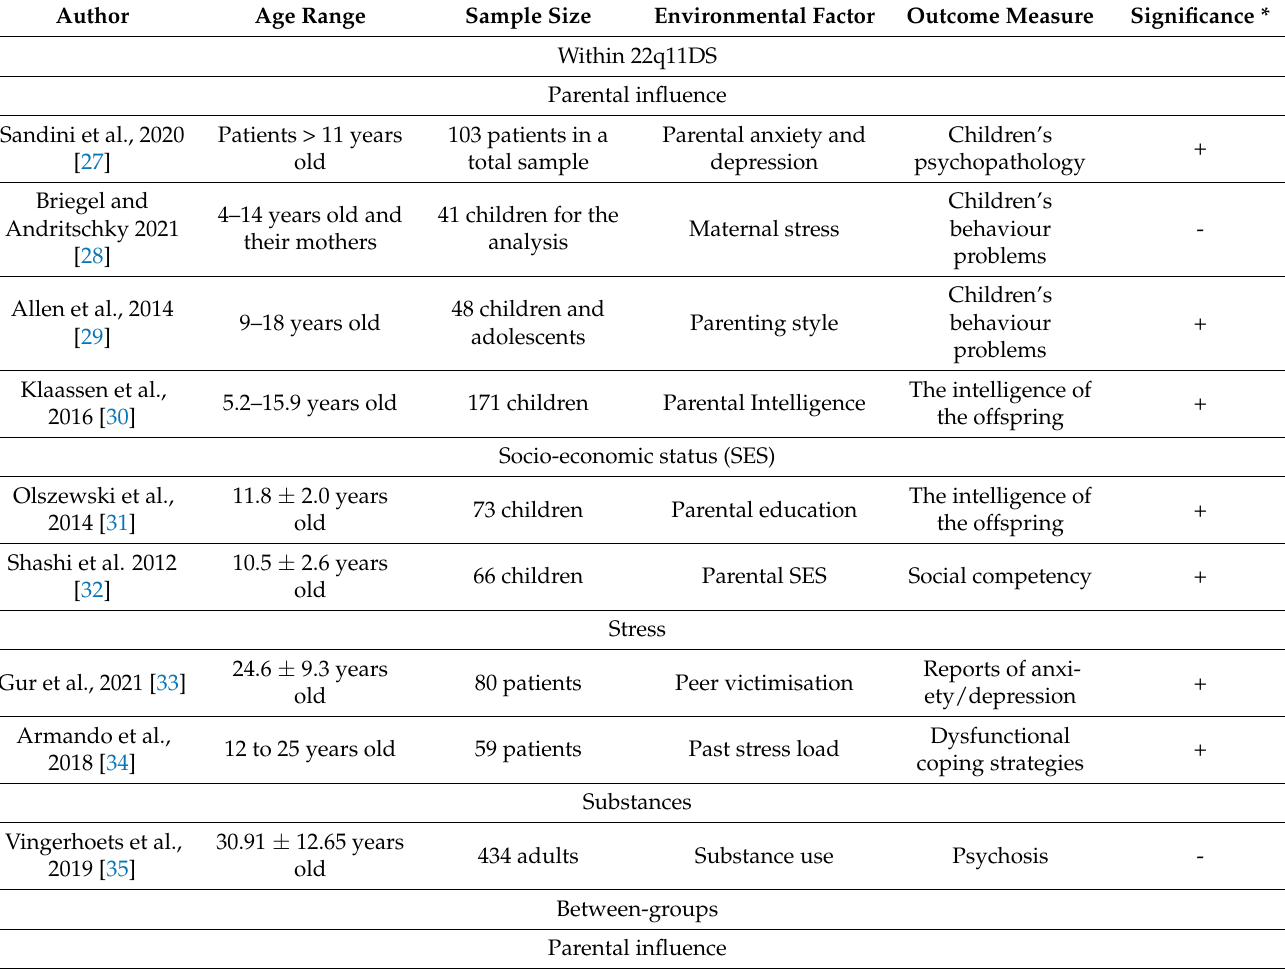
Table 1. Overview of the reviewed sources grouped by the type of the study separately for within 22q11DS and between-group